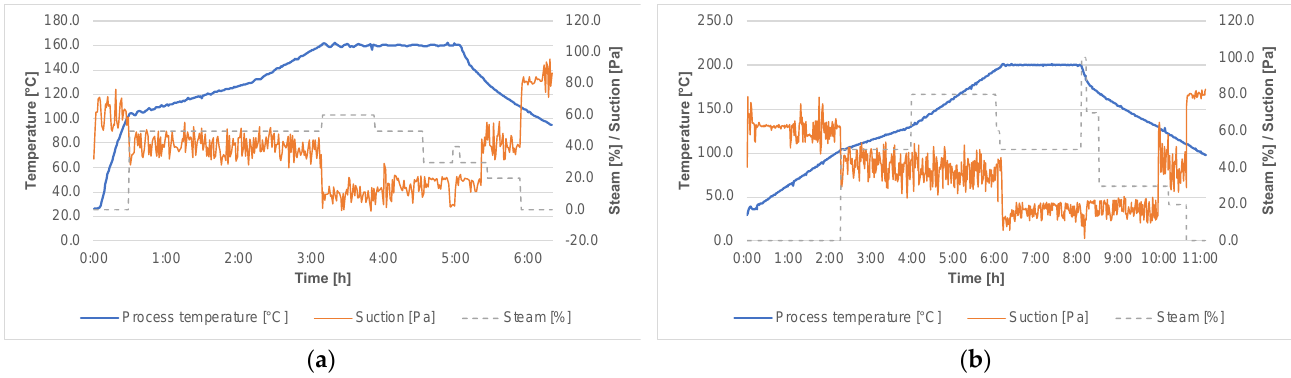
Figure 1. ( a ) (1) temperature 220 °C; (2) temperature 200 °C; (3) temperature 180 °C; (4) temperature 160 °C; (5) a reference sample without TM, ( b ) dimensions of the sample.